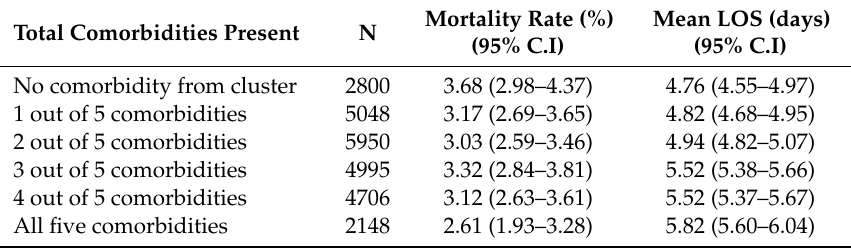
Table 7. Mortality rate and mean LOS according to the number of comorbidities present.